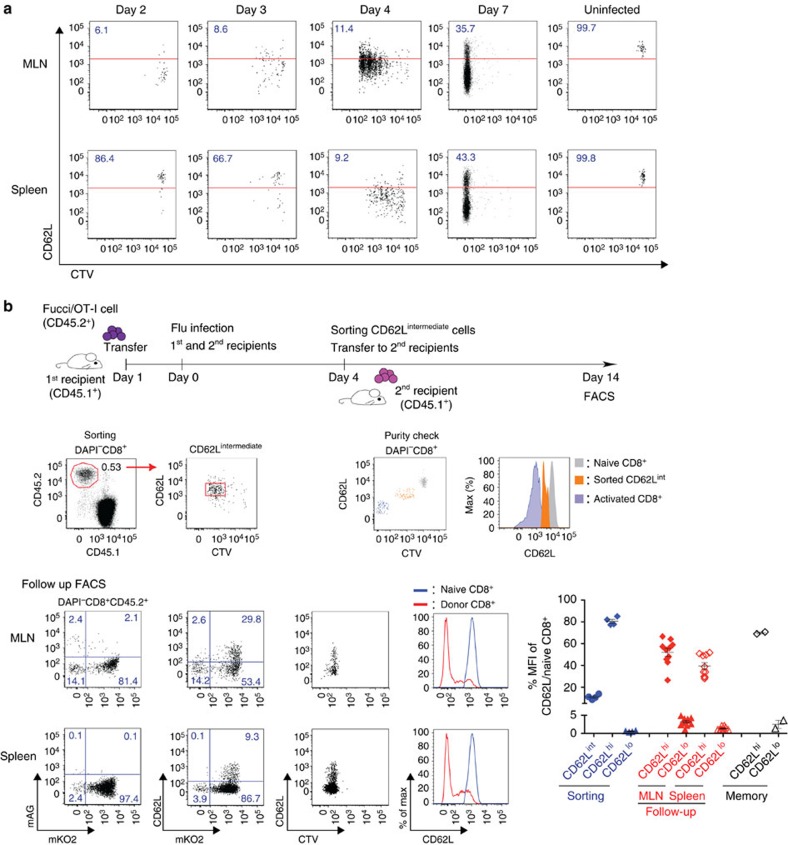
Proliferating virus-specific CD8+CD62Lint cells segregate into CD62Lhi and CD62Llo subsets.Magnetic-activated cell sorting-purified Fucci/OT-I (CD45.2+) cells were labelled with CTV dye and transferred to CD45.1+ recipients prior to PR8-OVA influenza A virus infection. (a) Surface expression of CD62L against CTV dilution on virus-specific CD8+ T cells in MLNs and spleens on days 2, 3, 4 and 7 p.i. Data are representative of three independent experiments with three to five mice each. (b) CD62Lint Fucci/OT-I cells in the 4th–8th divisions were sorted from splenocytes on day 4 p.i. and transferred into the concurrently infected 2nd recipients. Ten days after transfer, 2nd recipients were analysed for the change of CD62L level. The percentage of CD62L mean fluorescence intensities against naive CD8+ T cells is shown to compensate differences in fluorescence between sorter and analyzer instruments. Symbols show mean with s.d. (n=7). Data are representative of three independent experiments with three mice each.